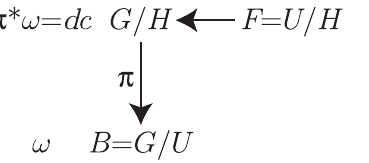
FIG. 1. Fibration responsible for the presymplectic structure. U ⊆ G is the subgroup that commutes with all Cartan generators 0 Þ . The base manifold B ¼ G=U is T with nonvanishing e i i ð symplectic, which describes the type- B NGBs, while the fiber F ¼ U=H describes the type- A NGBs. The symplectic form ω on B is pulled back to π (cid:3) ω ¼ dc on G=H . FIG. 2. Graphical representation of the fibration S 1 ↪ S 3 where the projection π is the Hopf map. On each point on S 2 , there is an S 1 fiber where the type-A NGB can fluctuate. The fiber on each point is shown with different colors. The type-B NGBs fluctuate on S 2 . On the left, the entire S 3 is shown using a stereographic projection onto R 3 . S 1 fibers are shown as circles, and the collection of circles form the entire S 3 . Note that every circle is intertwined with every other